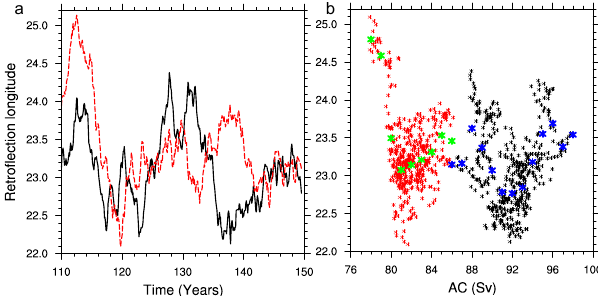
Fig. 8. (a) Five-year running mean of the longitude of the retroflec- tion in POP CTRL (black) and POP NoITF (red). (b) Longitude of the retroflection as a function of AC transport for POP CTRL (black) and POP NoITF (red) also filtered with a five-year running mean. Bigger crosses represent the average AL corresponding to a certain range of 1Sv of